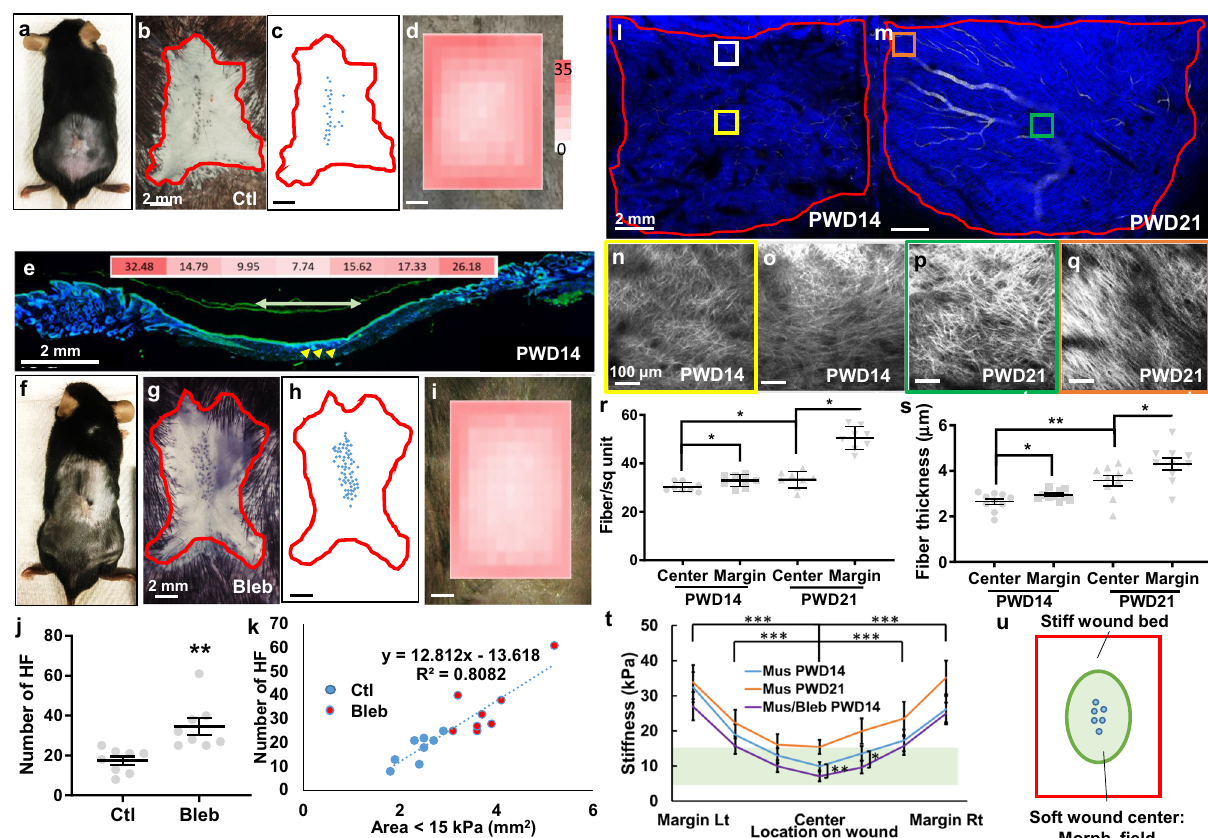
Fig. 1 Tissue mechanics set up morphogenetic fi eld for wound-induced hair follicle neogenesis. a A PWD28 C57Bl/6 mouse. b AP staining showing de novo hair follicle formation at the center of the wound bed at PWD28. c Schematic diagram showing the location of regenerated hair follicles (blue dots) in b . d Stiffness heatmap overlaying the PWD14 wound. Colorimetric unit: kPa. e Cross-sectional view of the PWD14 wound and distribution of wound stiffness. Yellow arrow heads indicate the formation of hair placodes. Heatmap and number indicate the spatial stiffness of the whole wound bed. Unit: kPa. Green arrow indicates the range of the morphogenetic fi eld. f A Bleb-treated mouse on PWD28. g AP stain showing the number of hair follicles increased signi fi cantly upon Bleb treatment. h Schematic diagram of hair follicles (blue dots) in g . i Stiffness heatmap of PWD14 Bleb-treated overlaying wound. j Dot plot showing changes in HF upon Bleb treatment. n = 8 biologically independent animals. Data are presented as mean values ± SEM. p = 0.003, unpaired two-sided t -test. k The area of the wound bed under 15 kPa positively correlates with the number of hair follicles. SHG of l PWD14 and m PWD21 wounds. The color squares indicate the location of corresponding enlarged photos from n PWD14 center, o PWD14 margin, p PWD21 center and q PWD21 margin of the wound image. r Dot plot showing the number of fi bers per square unit. PWD14 C/M: p = 0.0323, PWD14/PWD21 C: p = 0.0495, PWD21 C/M: p < 0.0001. s Fiber thickness in respective wound time and location. PWD14 C/M: p = 0.0454, PWD14/PWD21 C: p = 0.0020, PWD21 C/M: p <